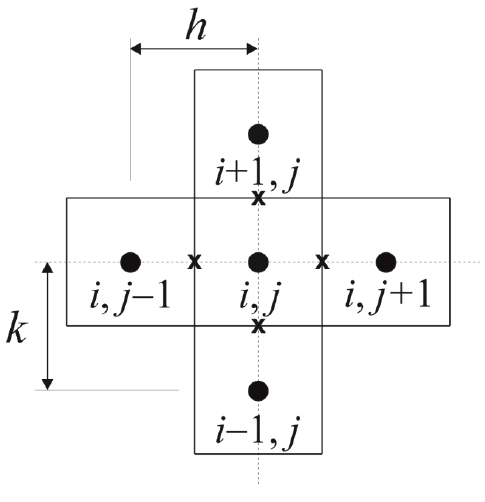
Figure 2. Five-point